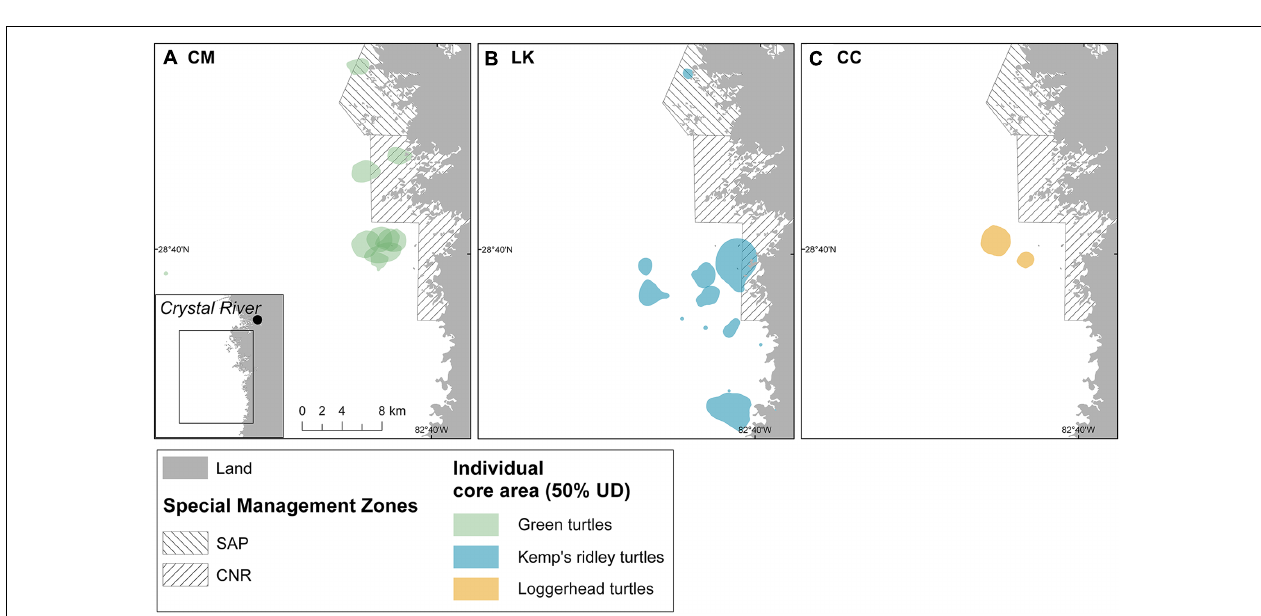
FIGURE 3 | Frequency of size classes of marine turtles captured between July and September 2016 in the Crystal River region, United States: (A) 43 CM green turtles; (B) 23 LK Kemp’s ridley turtles; and (C) 6 CC loggerhead turtles.